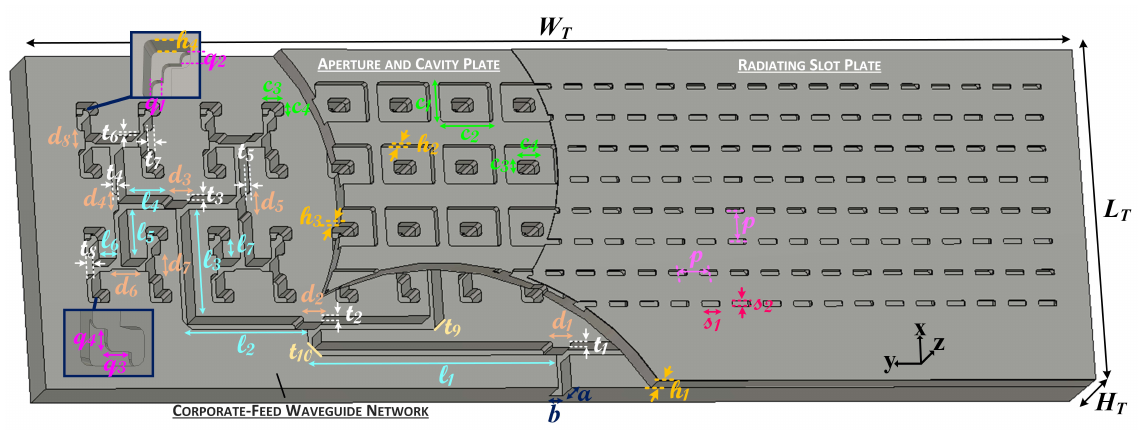
FIGURE 1. Configuration parameters of the proposed WSAA.